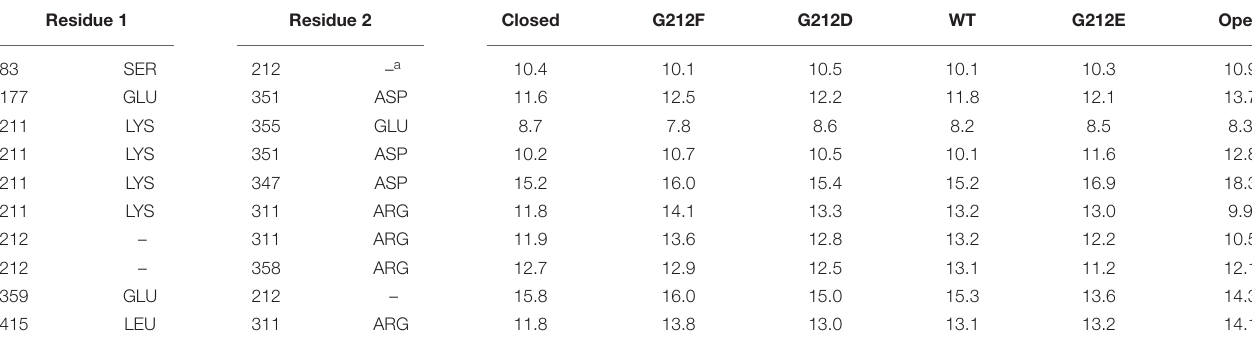
TABLE 1 | Distances between C α atoms of residues surrounding residue 212 in crystal structures and MD simulations starting from the closed ASIC1a model. Residue 1 Residue 2 Closed G212F G212D WT G212E